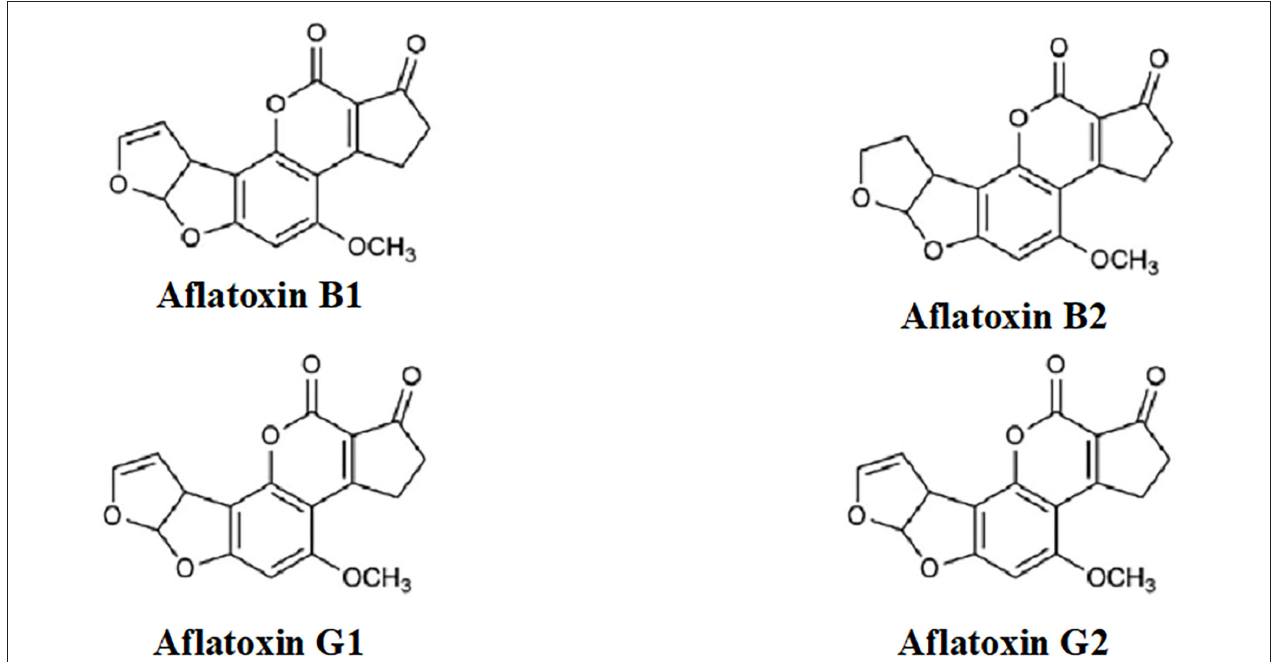
FIGURE 1 | Structures of